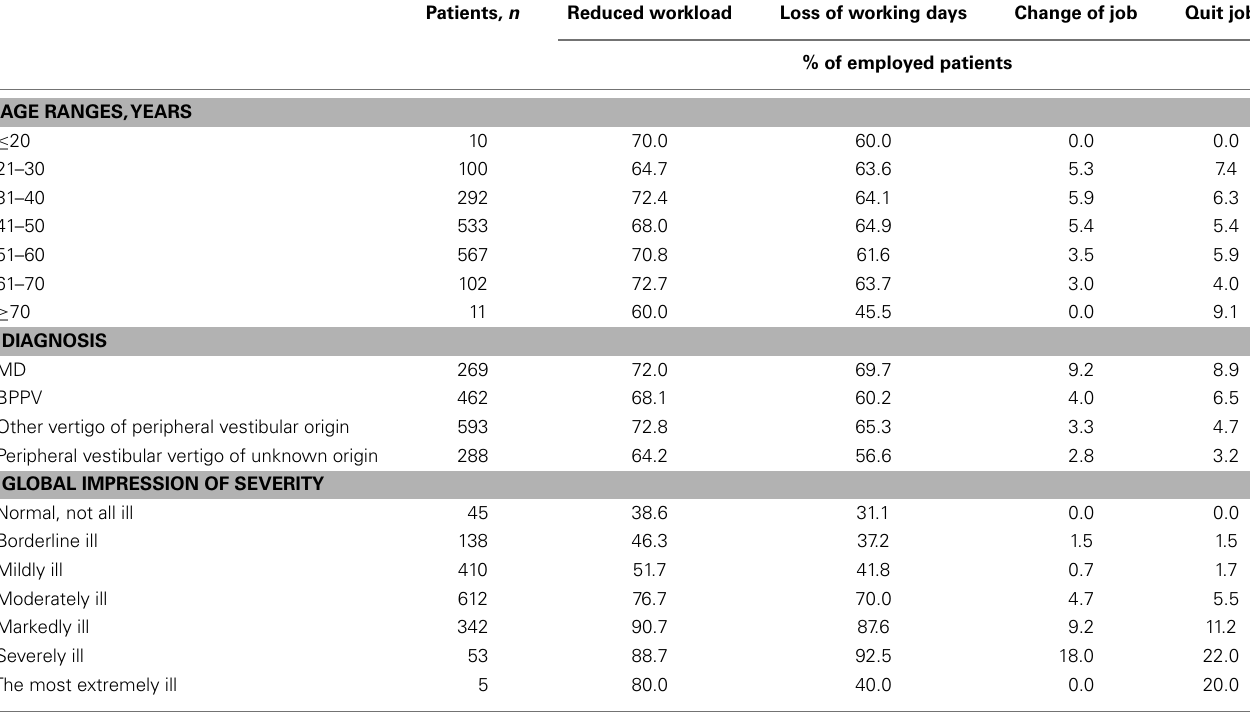
Table 3 | Impact of vertigo on the working status of the employed population, by age group, diagnosis, and illness severity in the 3months beforeVisit 1 (% of employed patients).